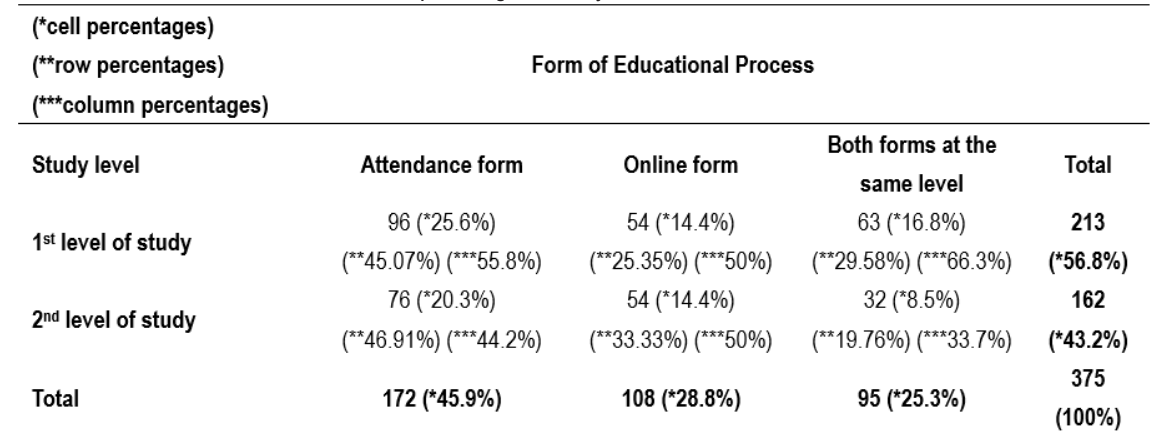
Preferred form of education depending on study level